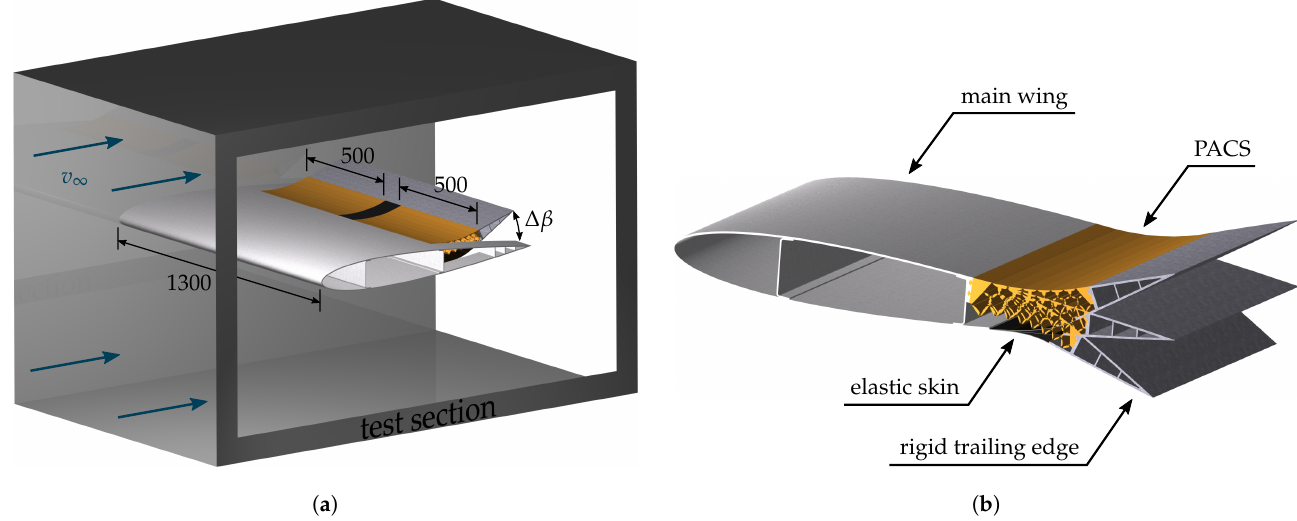
Figure 1. Wind tunnel model of a morphing aileron based on pressure-actuated cellular structures (PACS): ( a ) Model with two PACS actuators and a total width of 1300mm, integrated in wind tunnel test section. ( b ) Cutout of one actuator